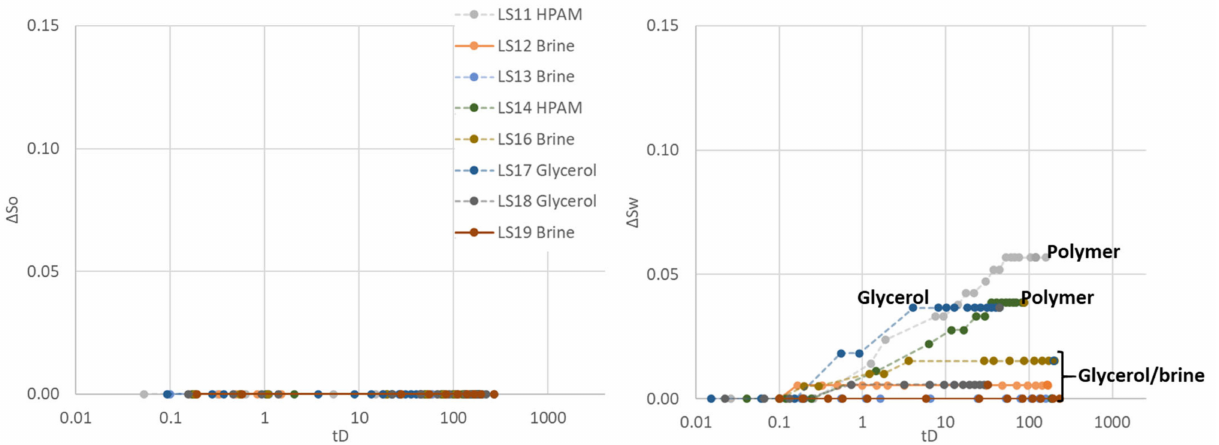
Figure 6. Oil ( left ) and water ( right ) saturation change as a function of dimensionless time during the fourth Amott–Harvey cycle. Note that the y -axis only represents a part of the mobile saturation range. The scale is kept constant for all cycles, to enable simple comparison of